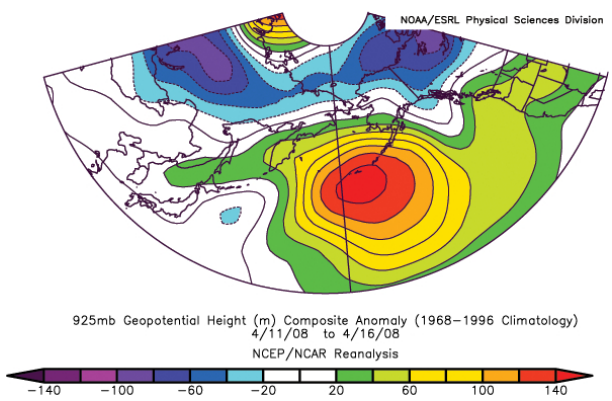
Fig. 10. Anomaly for the same date and parameter as shown in Fig. 9. The region of high pressure over the Aleutians during this period is not typical for this period.